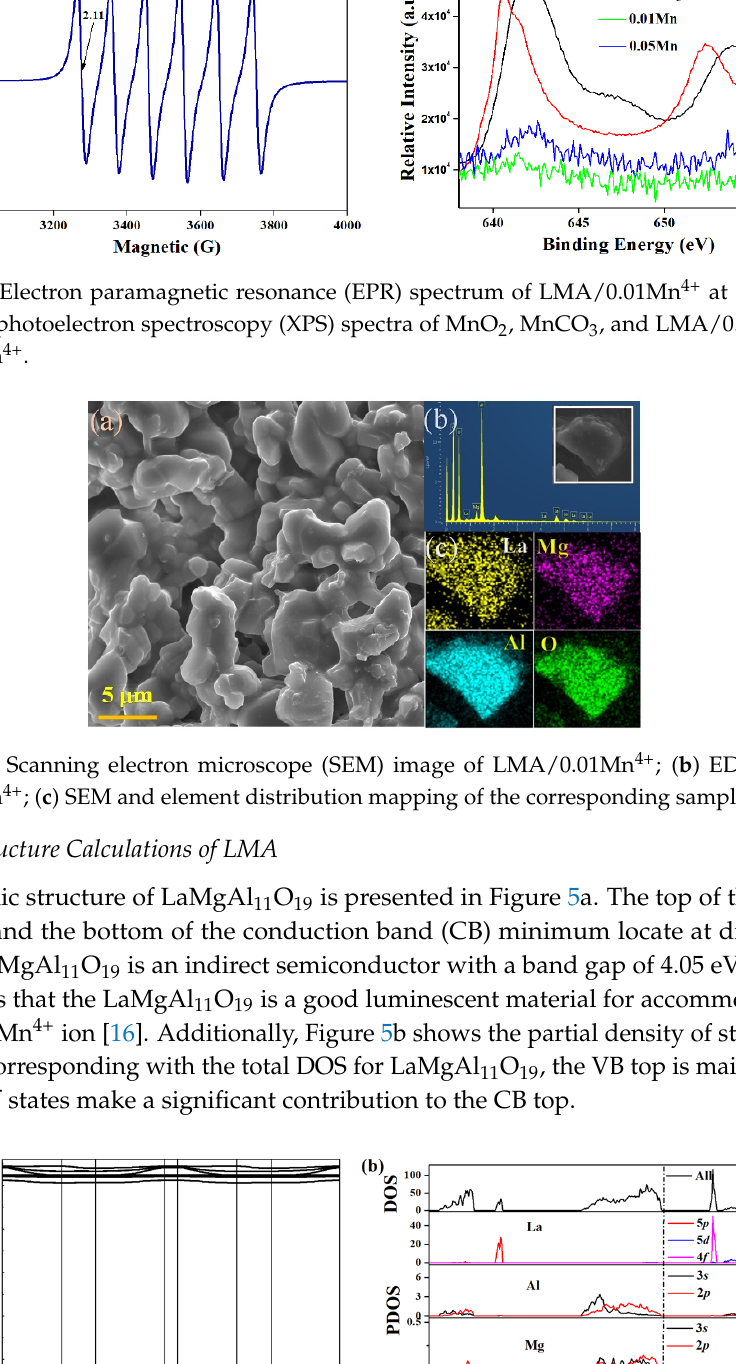
Figure 3. ( a ) Electron paramagnetic resonance (EPR) spectrum of LMA/0.01Mn 4+ at 77 K; ( b ) the Mn 2 p X-ray photoelectron spectroscopy (XPS) spectra of MnO 2 , MnCO 3 , and LMA/0.01Mn 4+ and LMA/0.05Mn 4+ .